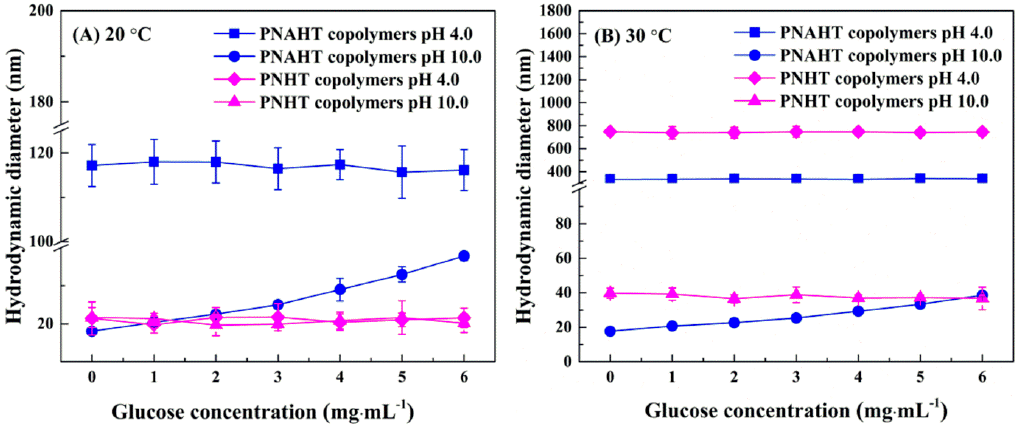
Figure 7. Changes in D AH of PNAHT and PNHT copolymers as plotted with glucose concentration at different temperature and pH.